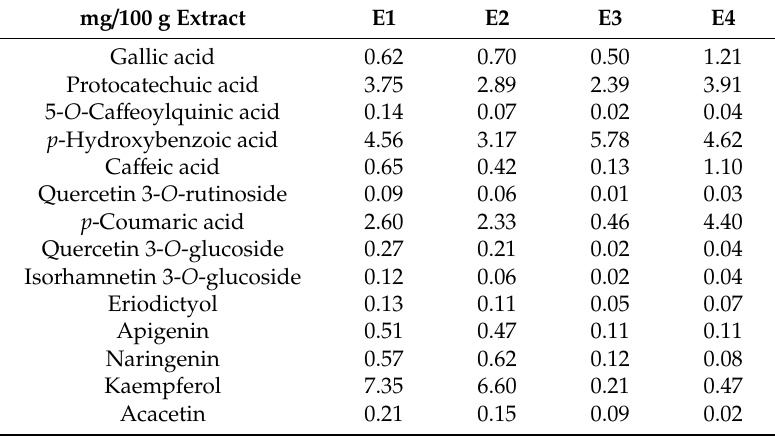
Table 3. Concentrations (mg / 100 g extract) of compounds in investigated extracts of the Hypnum cupressiforme according to the LC-MS